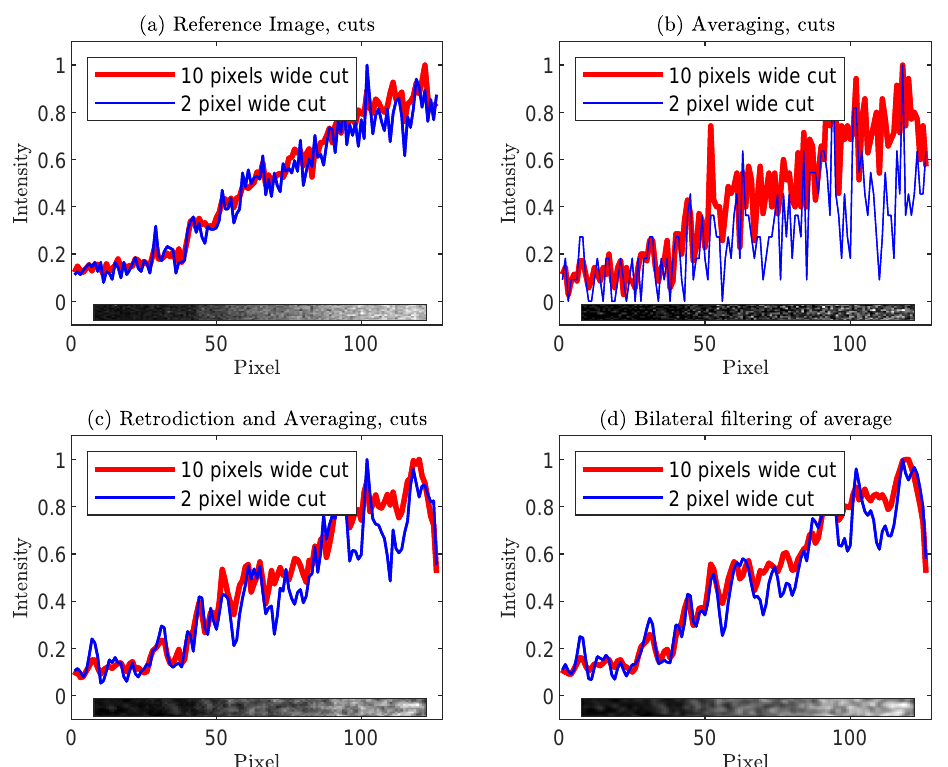
Figure 11. Cuts along the grayscale bar at the top of ( a ) the reference image shown in Figure 2a, ( b ) the averaging, ( c ) retrodiction and averaging, and ( d ) bilateral filtering methods for 2 µ s total exposure time images shown in Figure 6. In each case, the red line shows a ten pixel wide cut and the blue line a two pixel wide cut. In each case the grayscale bar portion of the original image has been reproduced as an inset at the bottom of each